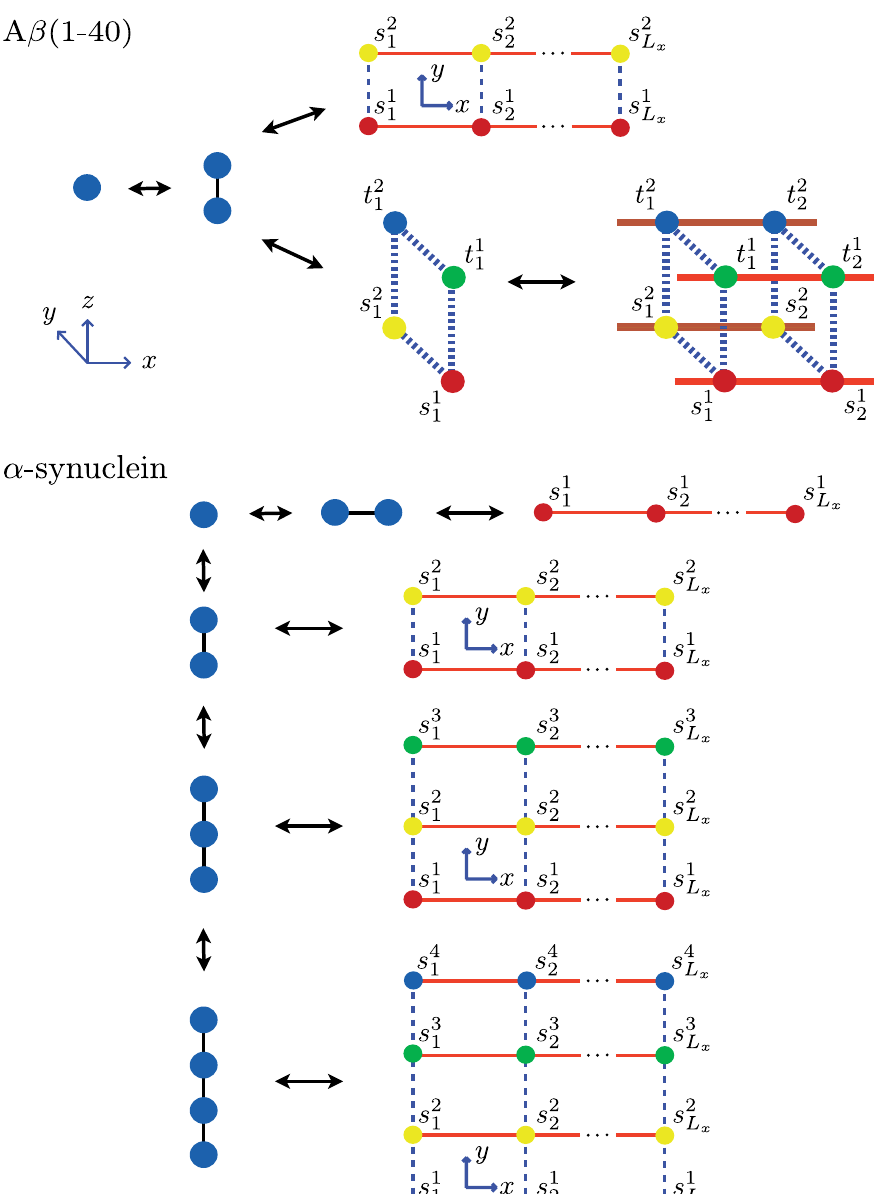
Figure 8. Partial lists of chemical species that may exist in dynamic equilibrium with fibrils for A β (1-40) ( top ) and α -synuclein ( bottom ). In the A β model, the different types of aggregates that could be present at equilibrium are 1D filaments, strips of length L that represent protofibrils, and 3D cubes that represent fibrils. The cubes are composed of two identical proto-fibrils stacked in-register. In the model for α -synuclein aggregates, L = 1, 2, 3, and 4 strip lattices are used to describe the aggregates at equilibrium, with y the L = 4 strip lattice representing the fibril. For both A β (1-40) and α -synuclein, we y = 2 assumed n c